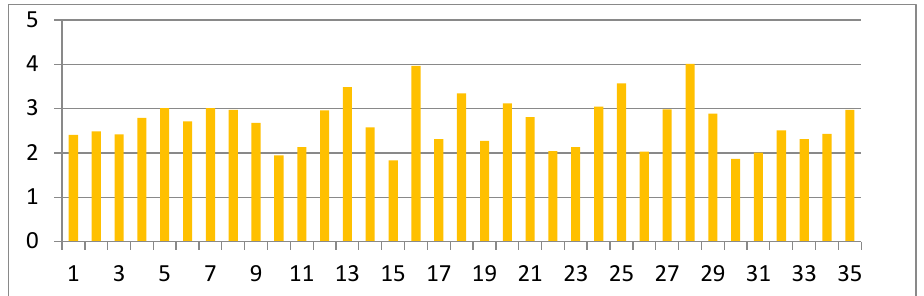
Figure 8.Gap changes of landmarks and its adjacent